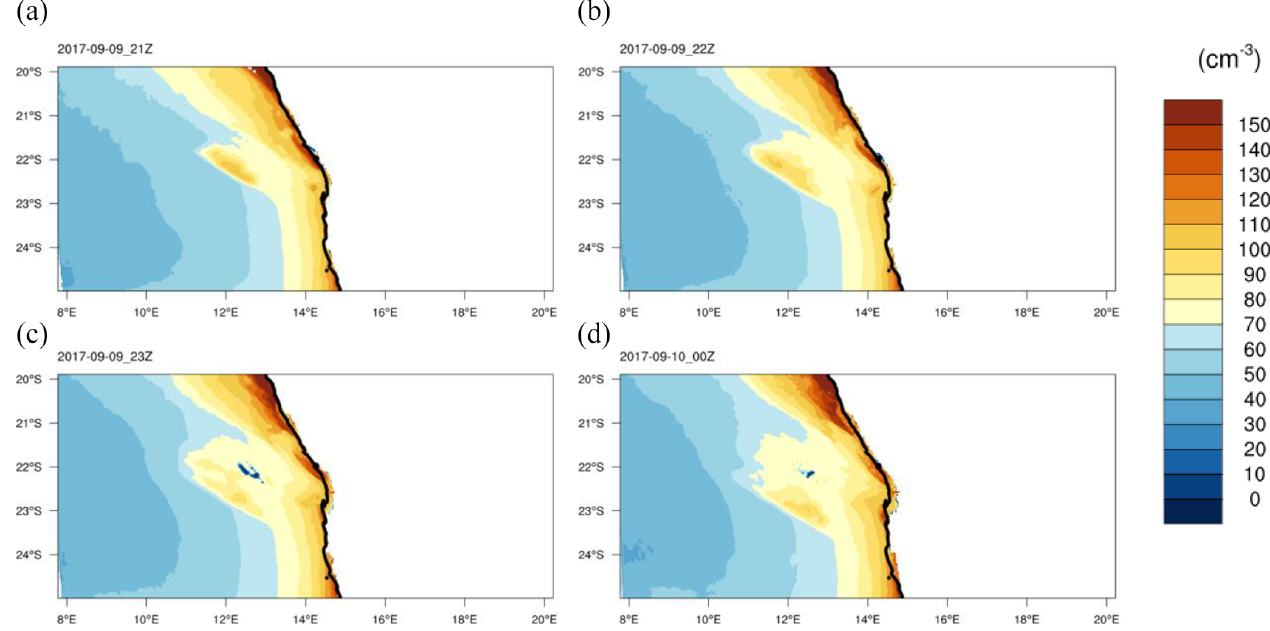
Figure 15. Cloud droplet concentration (cm − 3 ) onset for the event on 10 September 2017 for scenario CCN_ C10. The black dot is Henties Bay.